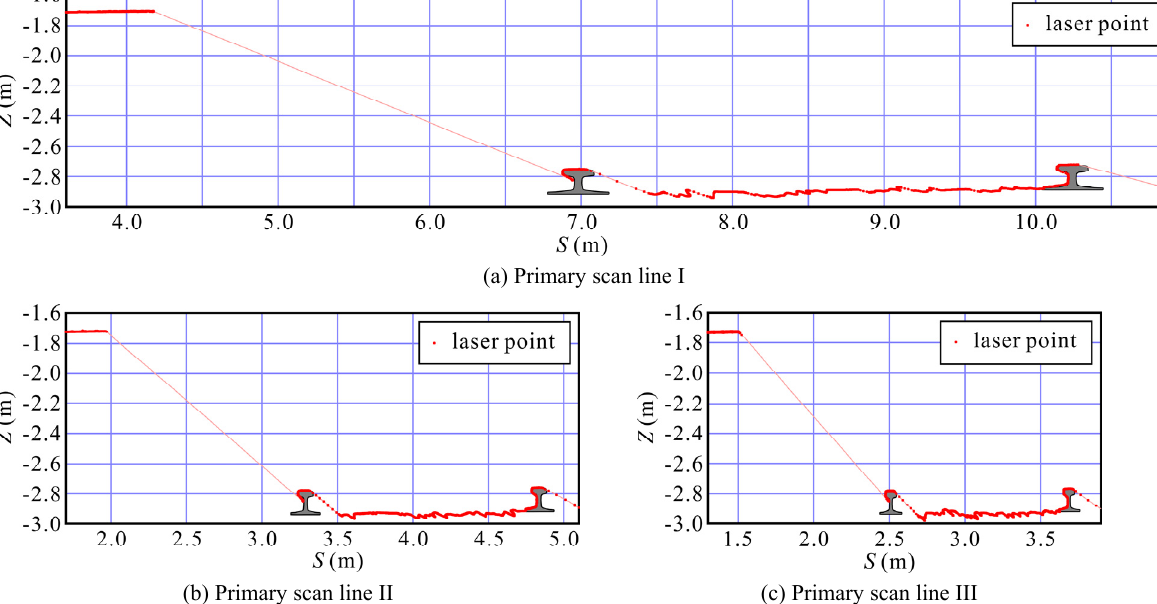
Figure 11. Laser points of the primary scan lines I to III ( S : horizontal distance from the scanner, Z : vertical